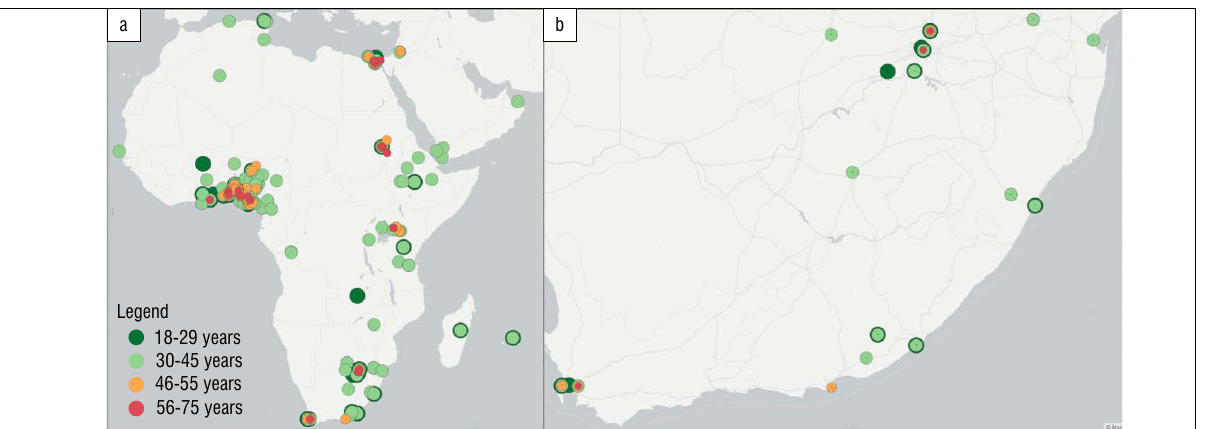
Figure 5: Cities represented by all (a) African-Arabian and (b) South African submissions, by age